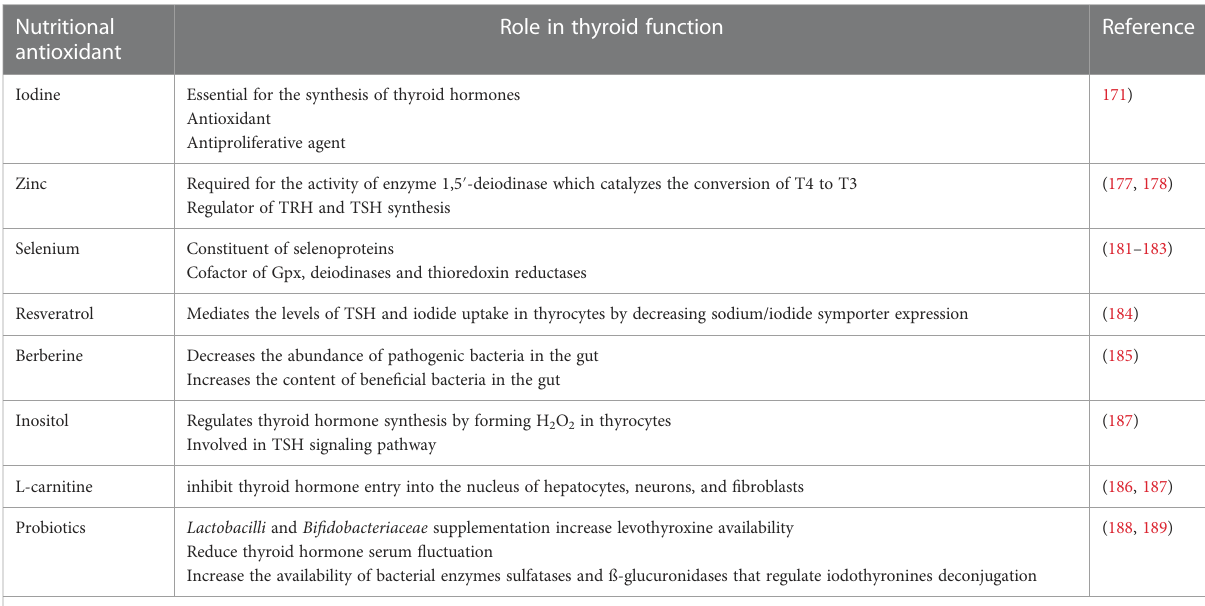
TABLE 1 The role of nutritional antioxidants in thyroid function.